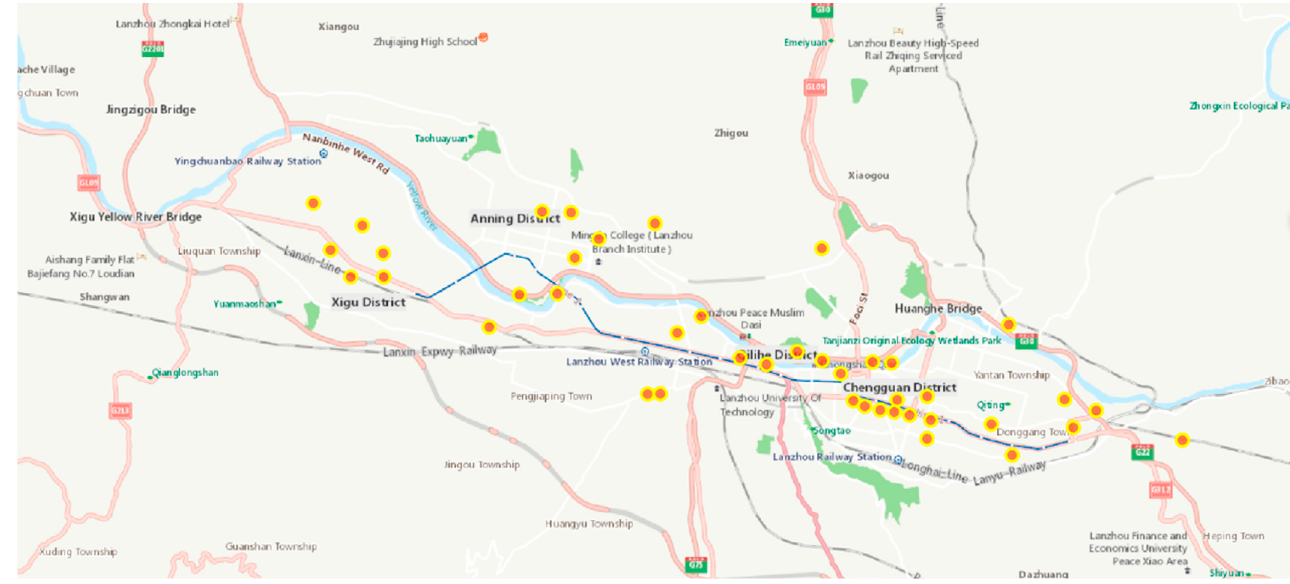
Figure 2. Labeled Map of Carsharing Stations in Lanzhou. Table 5. Parameters for the case studies.